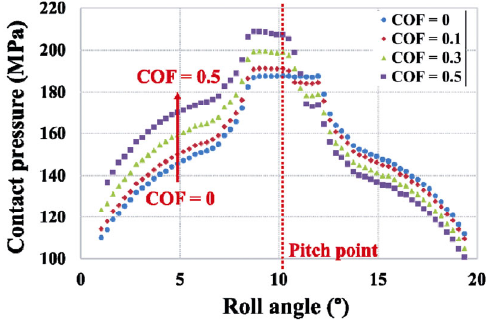
Fig. 2 Highest contact pressure values in each contact position with respect to COFs for a pair of bare gear teeth.